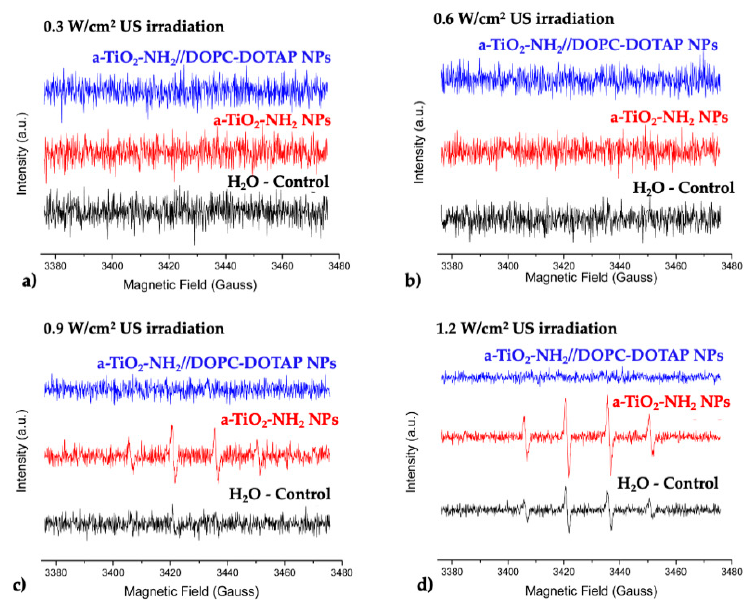
Figure 6. EPR spectra of a-TiO 2 -NH 2 based NPs (200 µg/mL) in water using DMPO (10 mM) as spin trap, irradiated with different US powers: ( a ) 0.3 W/cm 2 of US output power, ( b ) 0.6 W/cm 2 of US output power; ( c ) 0.9 W/cm 2 of US output power; ( d ) 1.2 W/cm 2 of US output power. Black spectra: control sample—water without NPs; red spectra: water with 200 µg/mL of a-TiO 2 -NH 2 NPs; blue spectra: water with 200 µg/mL of a-TiO 2 -NH 2 //DOPC-DOTAP NPs.